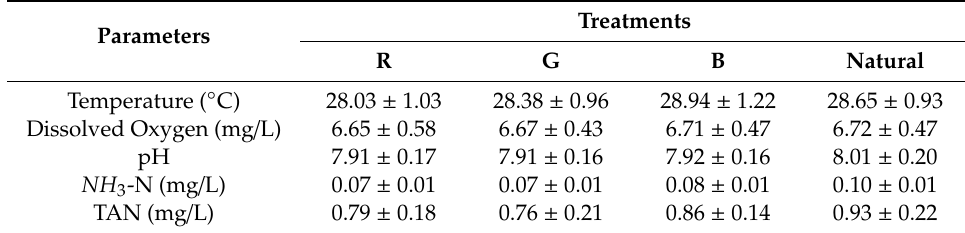
Table 3. Water quality parameters.